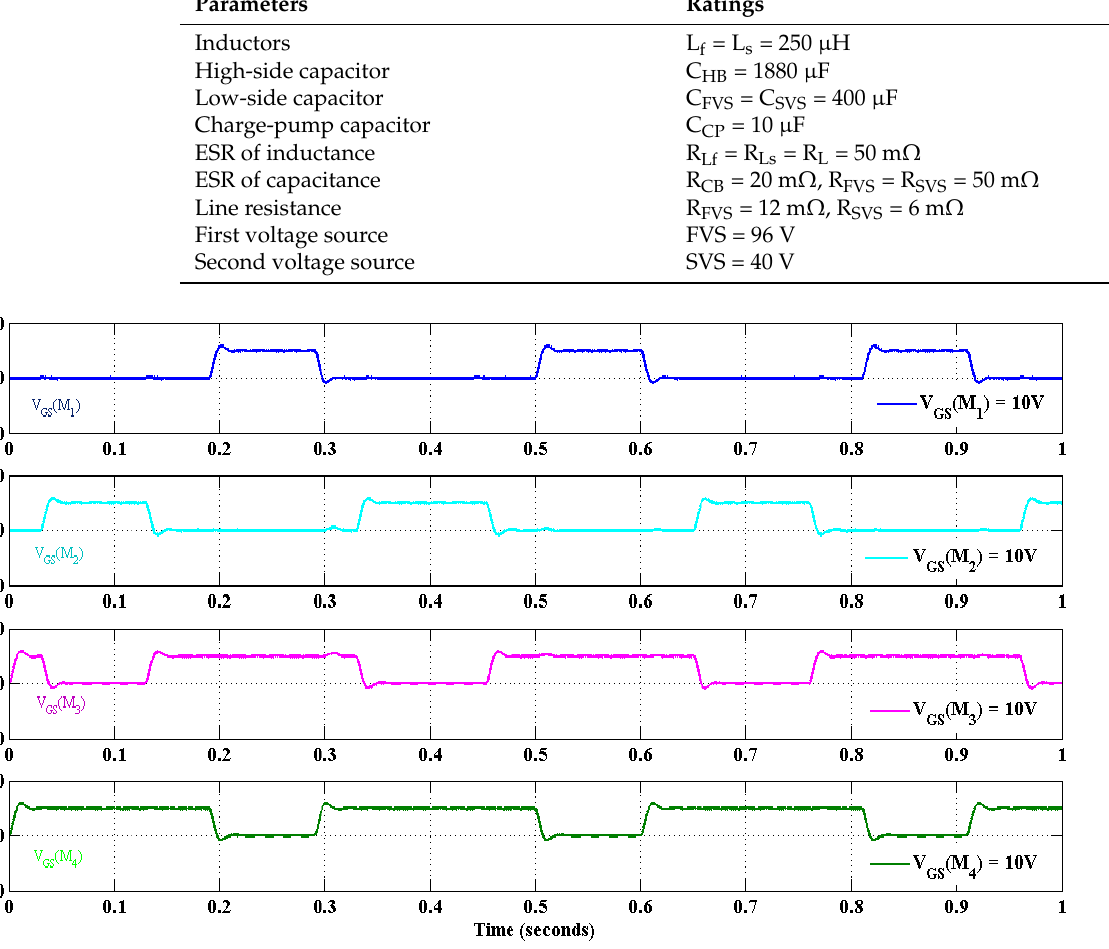
Table 2. Parameters and ratings of the HEV system.